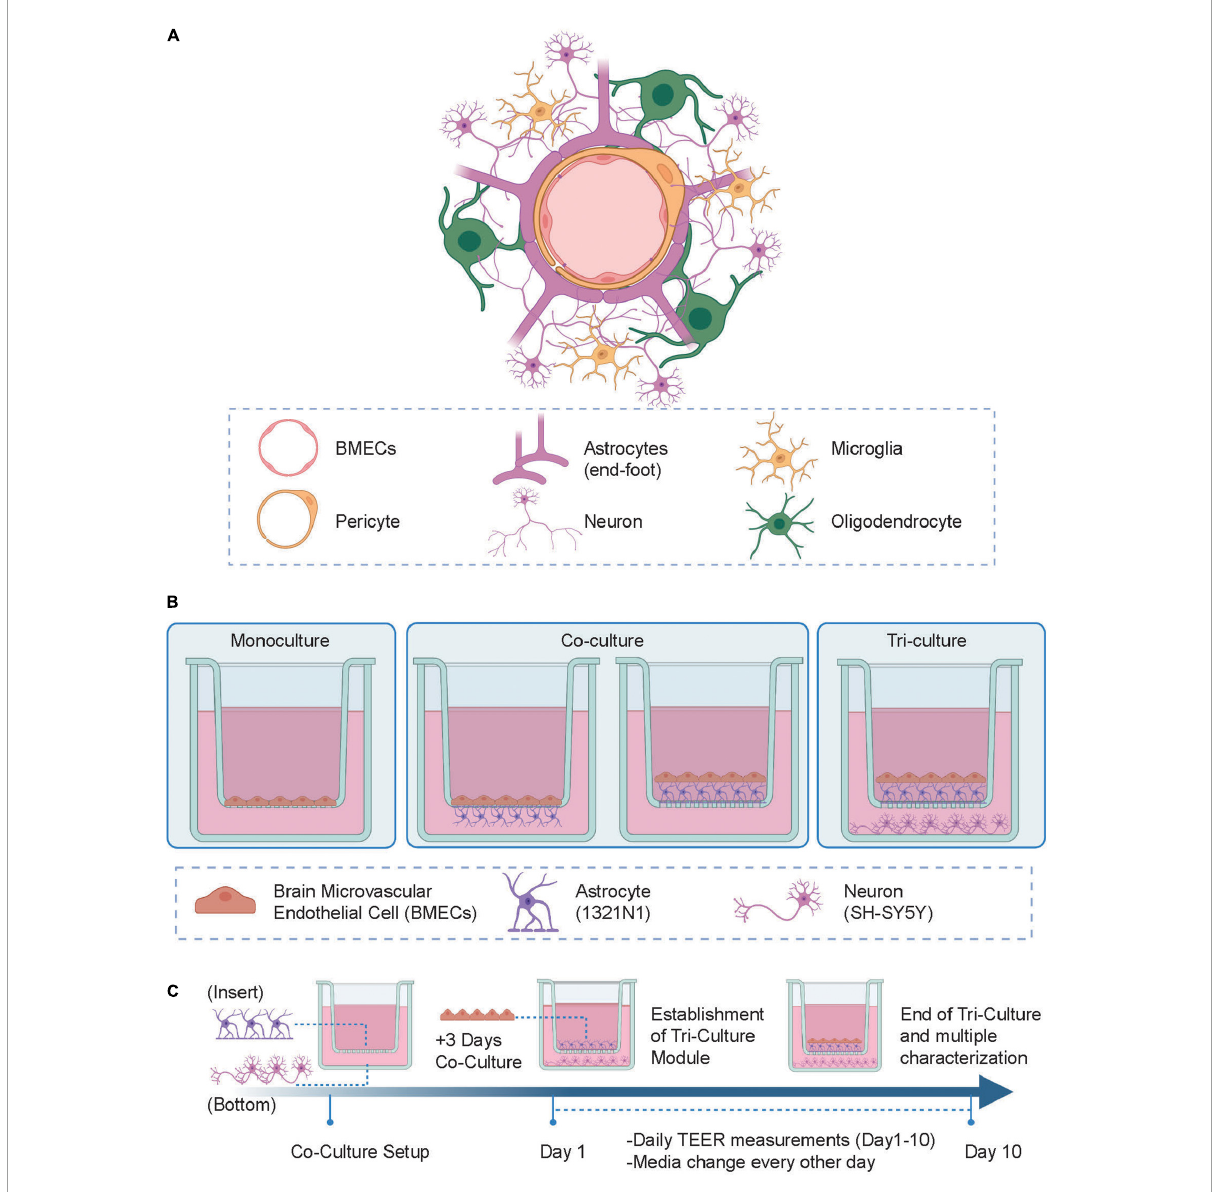
FIGURE1 (A) Schematic representation of the human neurovascular unit (NVU) in vivo . (B) Experimental setup of the tri-culture NVU model showing the various configurations of cells tested. (Left) In the monoculture setup brain microvascular endothelial cell (BMECs) are seeded in the apical